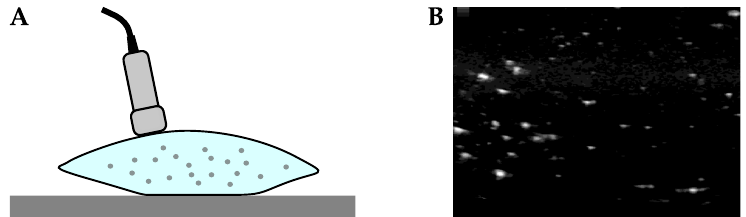
Figure 12. ( A ) An illustration of the apparatus used to demonstrate ultrasound imaging of MPs. PE bags were filled with suspensions of several types of MPs in tap water, and an ultrasound probe was applied to the outer surface of the bag to image its contents. ( B ) An image captured by the ultrasound machine system of PE MPs ranging from 125µm to 150µm in